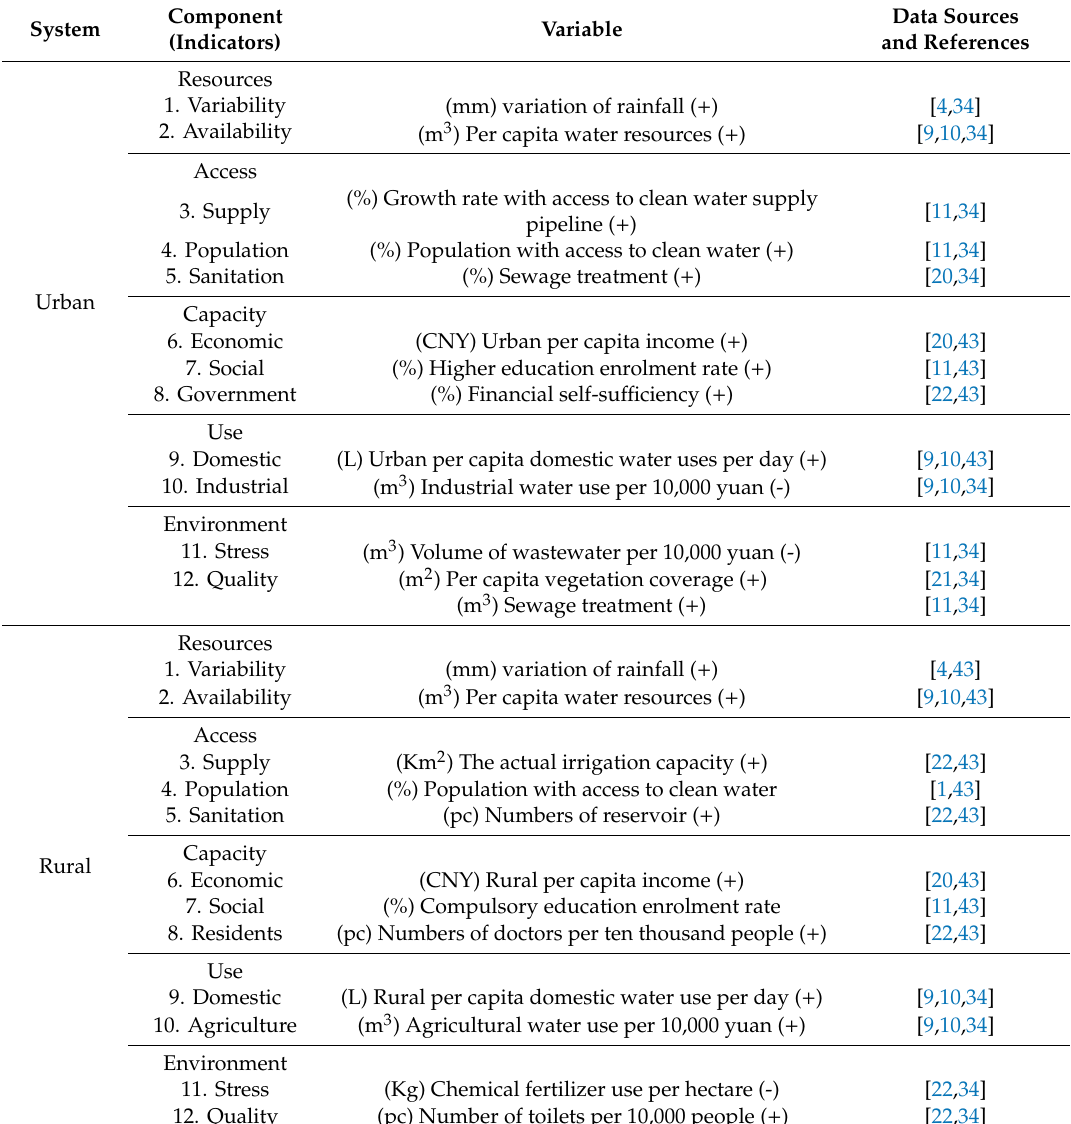
Table 1. Details of the WPI components, indicators,